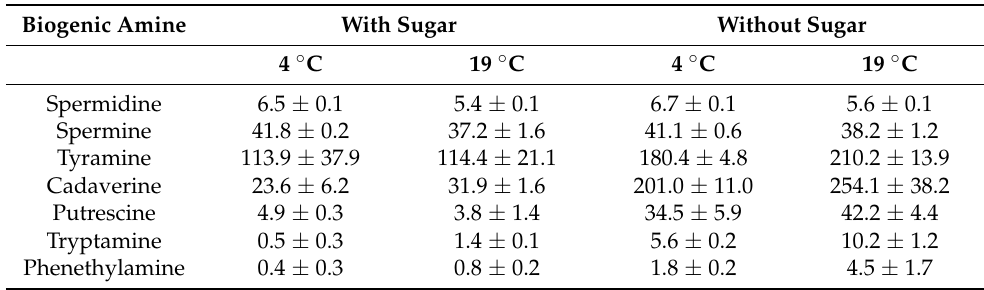
Table 11. Biogenic amine contents of fermented sausages with and without sugar after 20 days of storage (mg/kg)